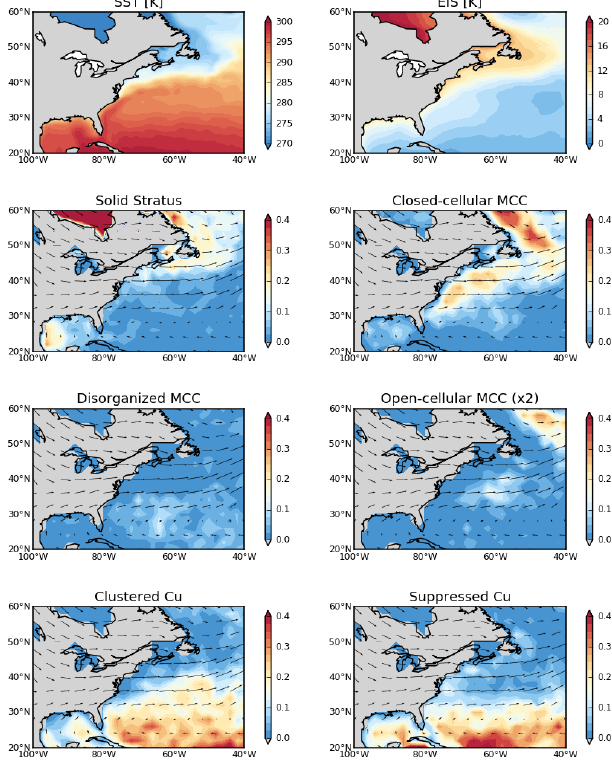
Figure 8. Frequency distributions of six morphology types obtained from the classification algorithm in the northwestern Atlantic region off the east coasts of USA and Canada in the winter of 2011. The top two panels show the SST and EIS distributions using MERRA- 2. Seasonal mean wind vectors at 850hPa are plotted to illustrate the flow. We double the values for frequency of the open-cellular type to make them numerically comparable with other